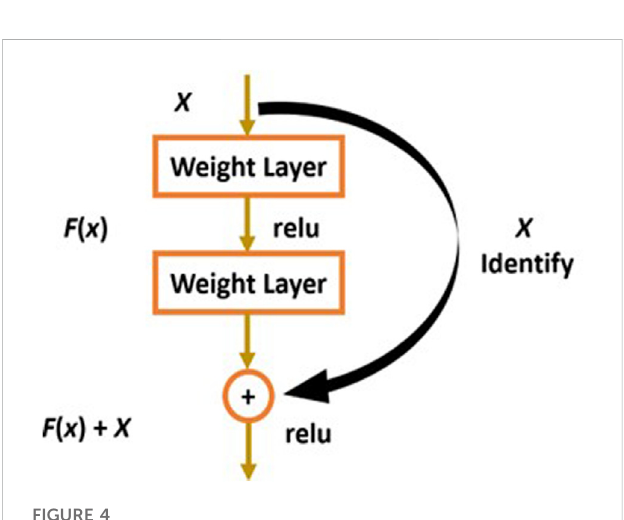
FIGURE 4 Residual blocks of ResNet Network.